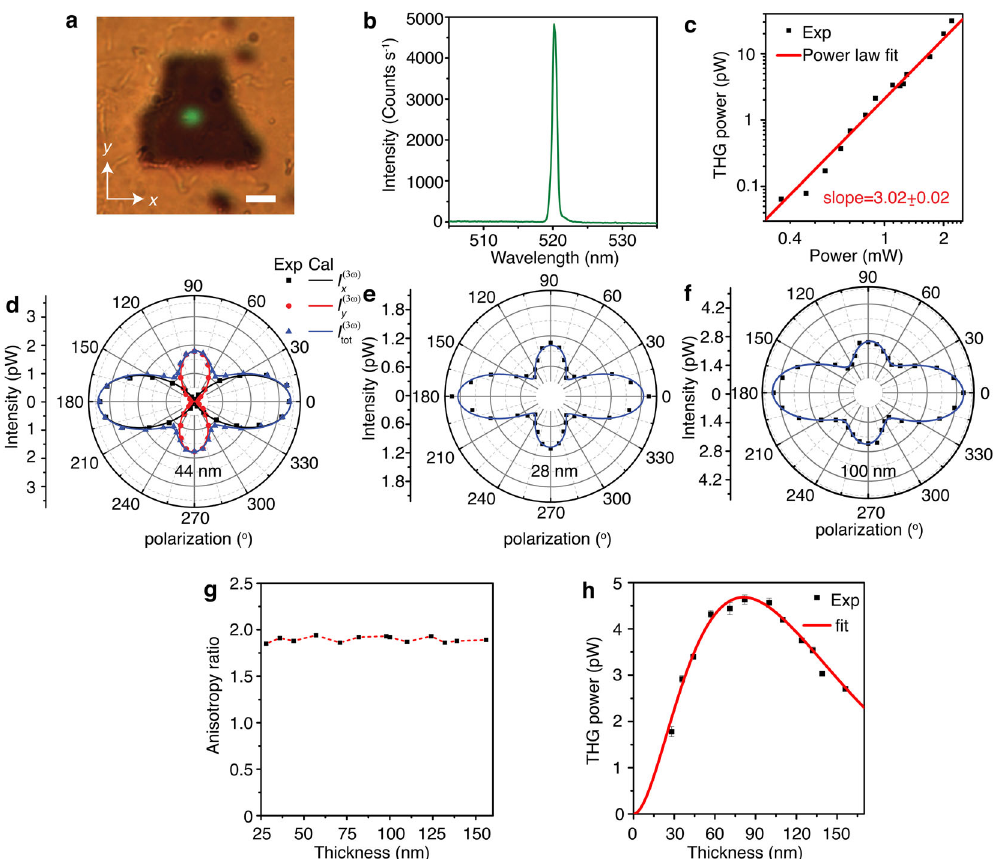
Fig. 5 Anisotropic THG in lengenbachite crystals. a Transmission microscope image of THG emission from the 44 nm-thick lengenbachite fl ake. Scale bar is 2 µm. b Measured THG emission spectrum from the fl ake. c Double log-scale plot of the measured THG power as a function of the pump power. d Angular dependence of the THG power on incident linear polarization angle of the pump beam for the 44 nm-thick fl ake. e , f Polar pts of the polarization-dependent THG response for two other fl akes of thicknesses 28 and 100 nm. g Measured THG anisotropy ratio as a function of the fl ake thickness. h Evolution of the average THG power versus the fl ake thickness for incident linear polarization along the rippling